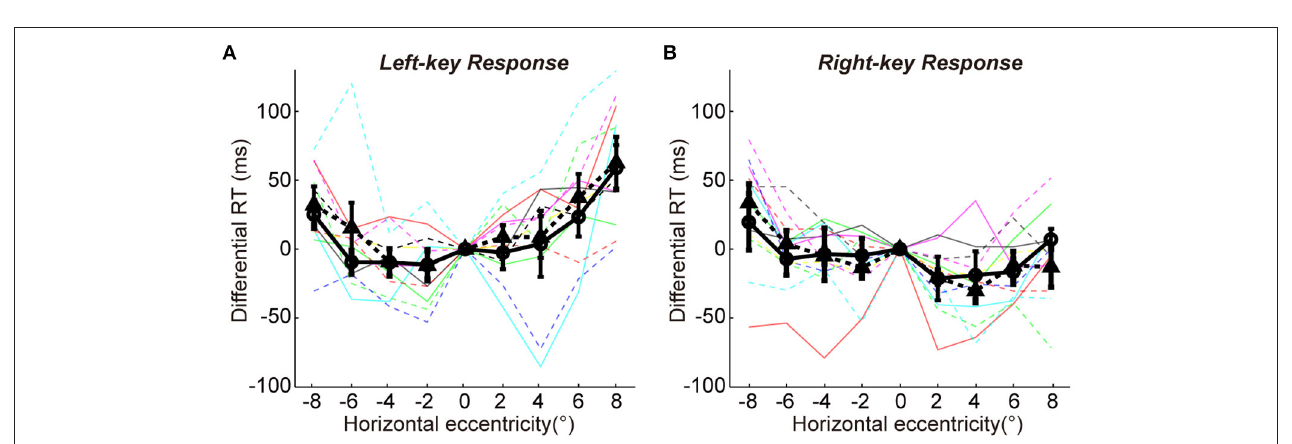
FIGURE 5 | The differential RTs in color discrimination task. The differential RT is plotted against the color patch horizontal eccentricity with left-key (A) and right-key (B) response. The solid black curve (through circles) and dashed black curve (through triangles) represent mean differential RTs with left-key and right-key responses, respectively. The black vertical bars denote ± SEM. The thin solid and dash color lines represent the differential RTs of individual subject with left-key and right-key responses,